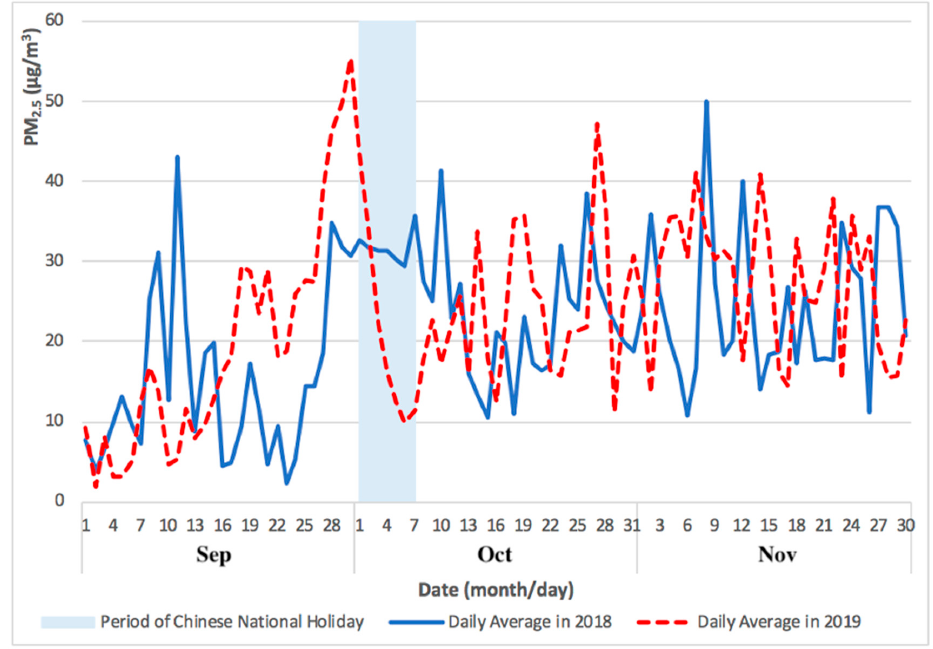
Figure 1. PM 2.5 concentrations for Taipa Ambient highlighting a pollution episode immediately before, and during, the Chinese National Holiday of 2018 and 2019 (September to November). Int. J. Environ. Res. Public Health 2020 , 17 , x